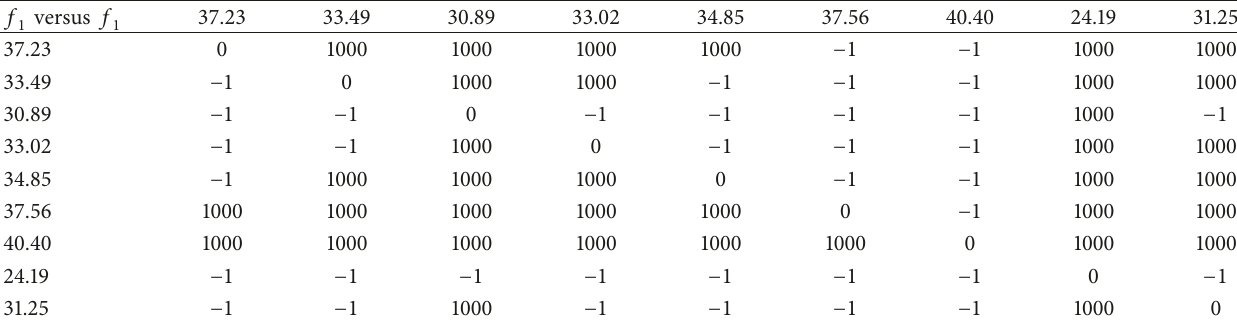
compares all the solutions k from objective f 1